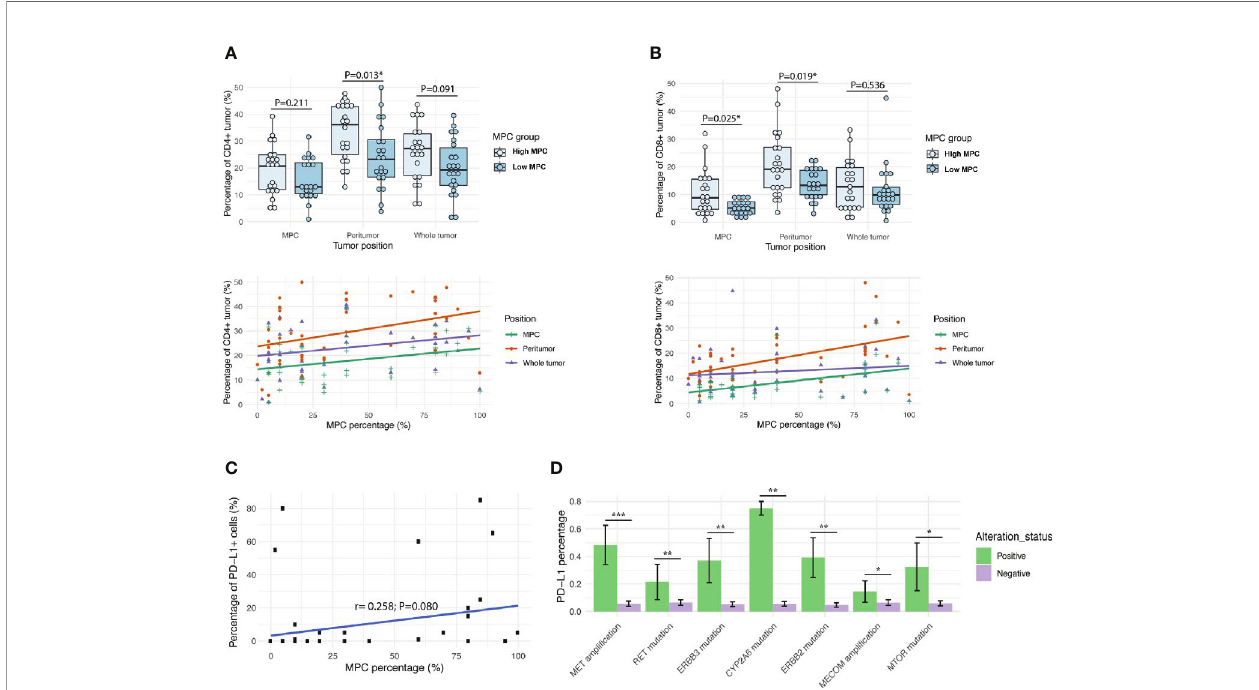
FIGURE 4 | LADC tumors with higher micropapillary contents have more T cell in fi ltration and immunosuppression. The pattern of immune cell in fi ltrations of CD4+ (A) and CD8+ (B) detected in different regions of tumor and comparison of micropapillary tumor content and the immunological markers. Upper panel: high MPC tumors vs . low MPC tumors; lower panel: the MPC percentage of the whole tumor. The Pearson ’ s coef fi cient value (r) and the corresponding P value were attached for each immunostaining; (C) The scatterplot of MPC percentage of the original tumor and the percentage of PD-L1+ cells within the MPC; (D) Graphs showing the top genetic alterations that were associated with the percentage of PD-L1+ tumors. *p < 0.05, **p < 0.01, and ***p <